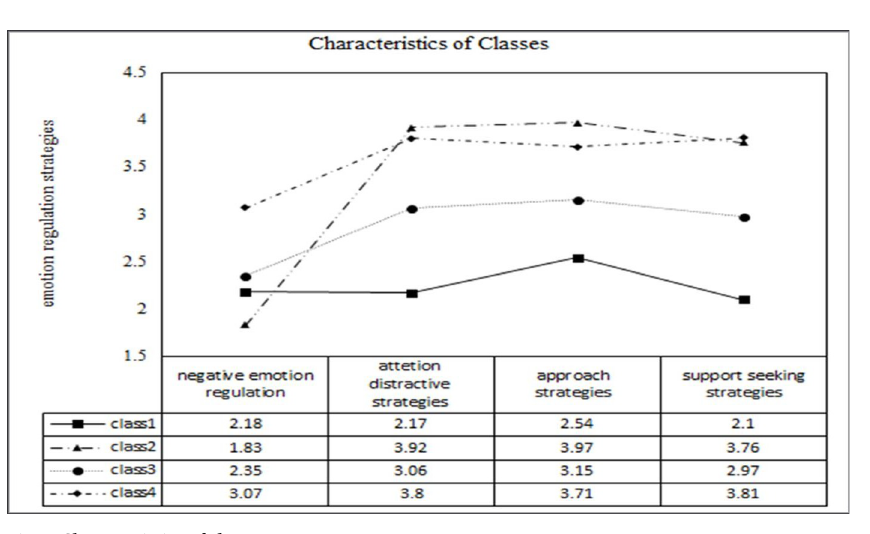
Fig 2. Characteristics of classes.